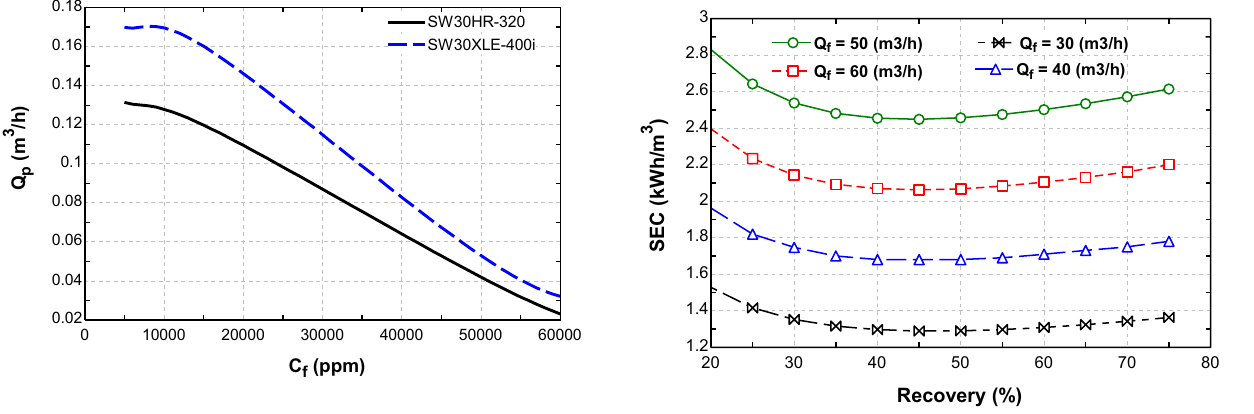
Fig. 7 The effect of recovery with SW30HR-320 on SEC in different flow